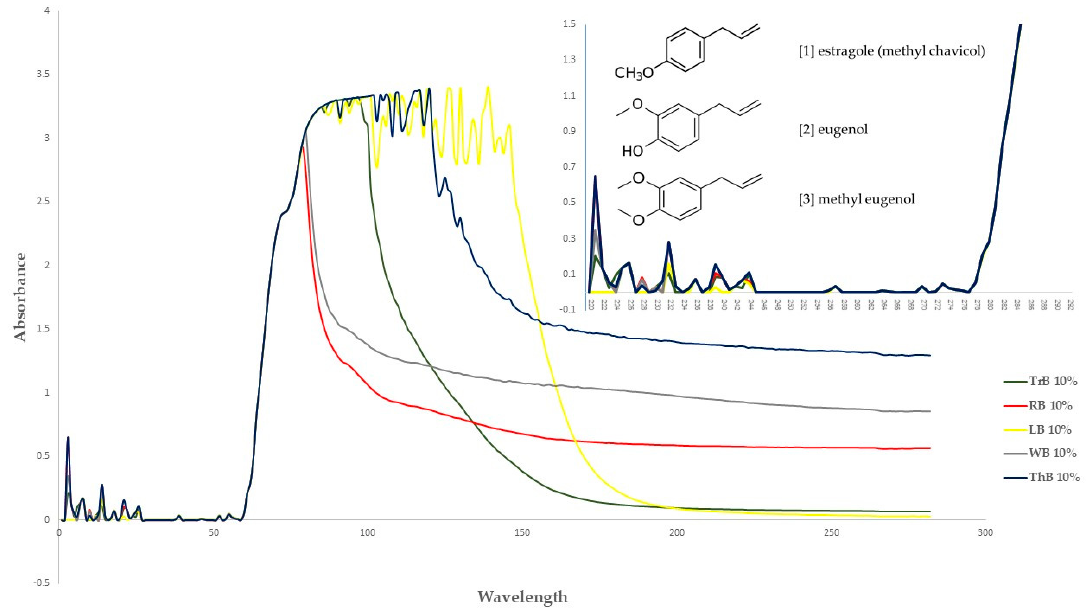
Figure 1. UV-Visible spectra of the essential oils from five Ocimum spp. The insertion is the inset evidences of the peaks between 220 – 280 nm and chemical structures of (1) estragole, (2) eugenol, (3) methyl eugenol. The essential oil was diluted in methanol. LB = Lemon basil ( O. citriodorum ); RB = red Holy basil ( O. sanctum var. Shyama); ThB = Thai basil ( O. basilicum var. thyrsiflorum); TrB = Tree basil ( O. gratissimum ); WB = white Holy basil ( O. sanctum var. Rama).